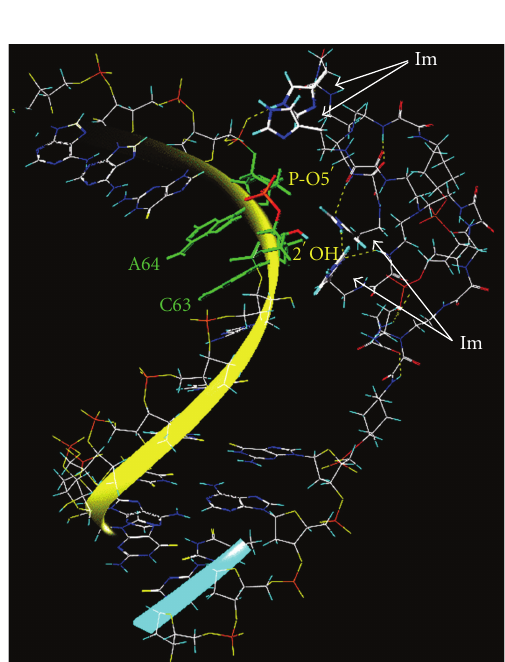
Figure 5: A fragment of the most favourable conformation, F4- Im(4/1), found for hybrid complex H- Im(4/1) between artificial ribonuclease B-Im(4/1) and tRNA Phe where the close proximity of imidazole cleaving groups to the target sequence C 63 -A 64 (green) is evident. Hydrogen bonds are shown in